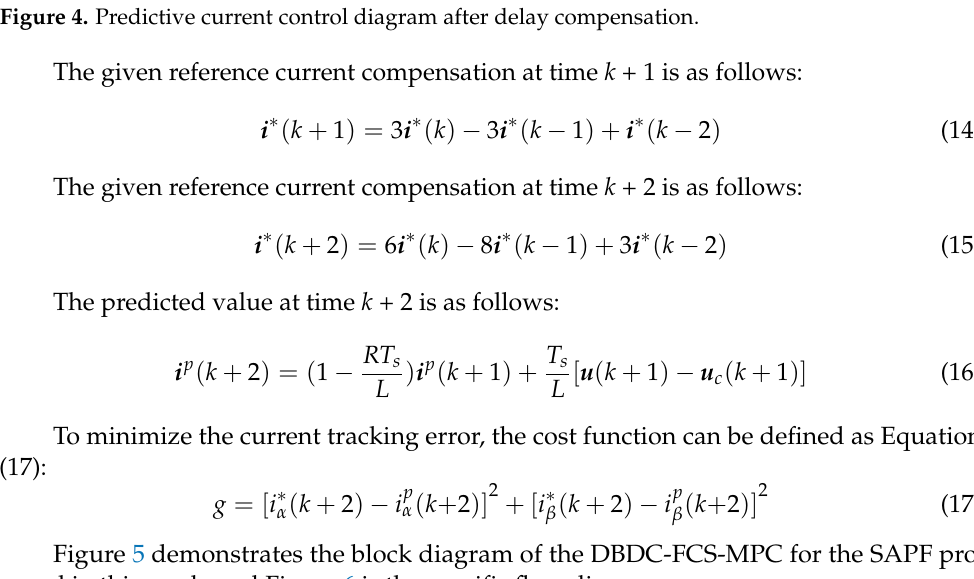
Figure 5. Control block diagram of SAPF system based on the DBDC-FCS-MPC strategy.